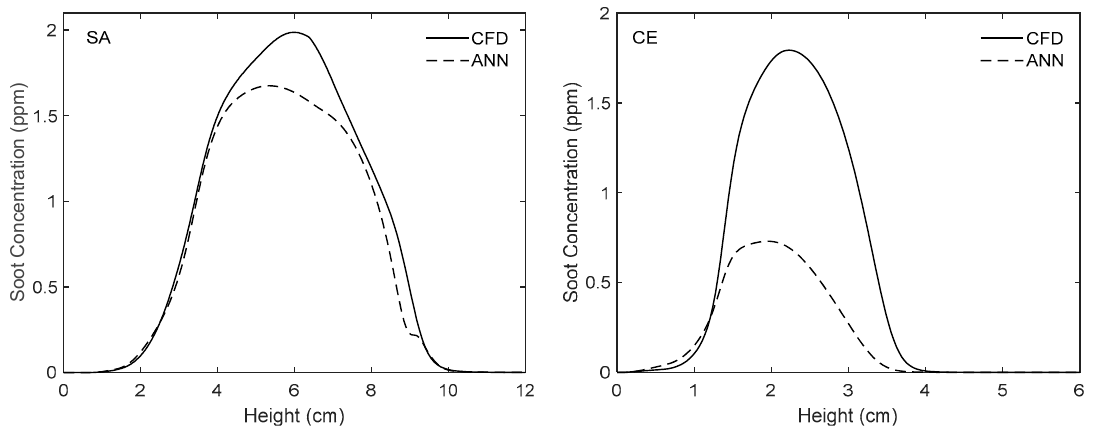
Figure 14. Comparison of experimentally-validated CFD results and those obtained from the ANN along the centerline for the flames used to test the network.